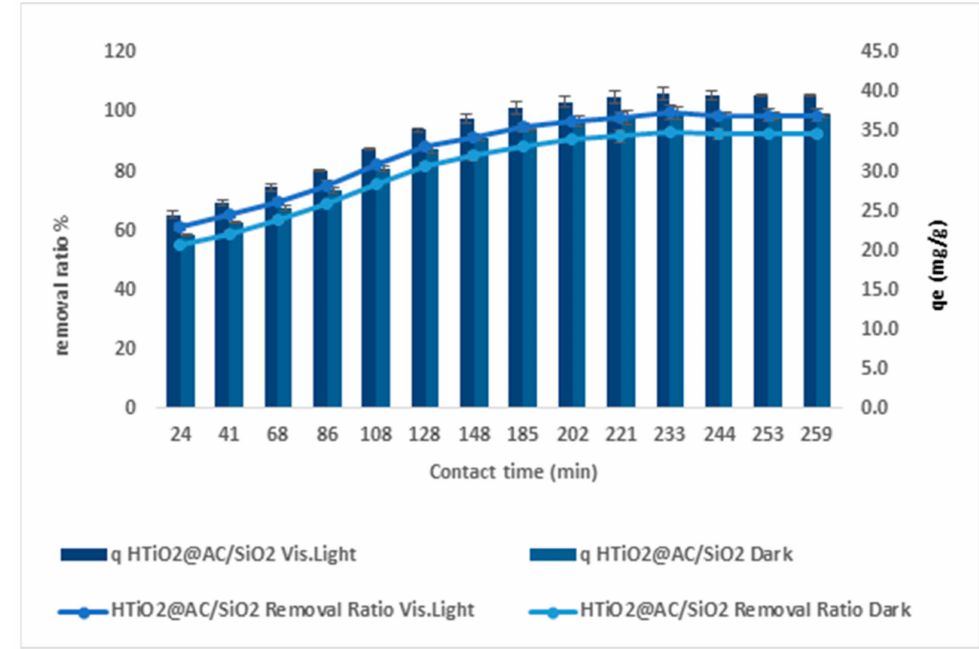
Figure 11. Contact time